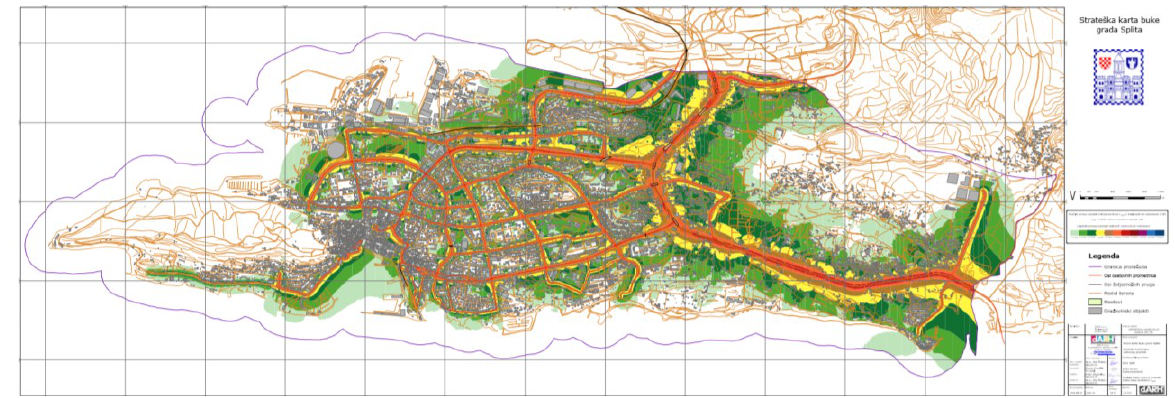
Figure 2. Strategic noise map of road traffic of the city of Split (DARH 2,